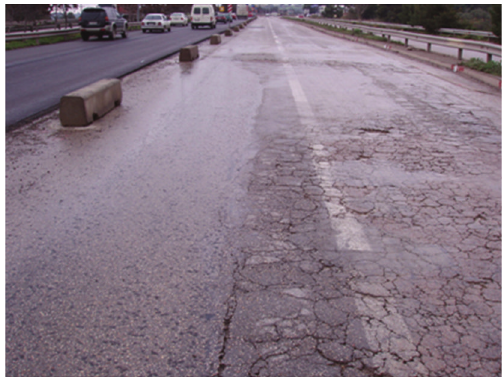
Figure 2: Distressed pavement of the heavy duty highway under investigation.